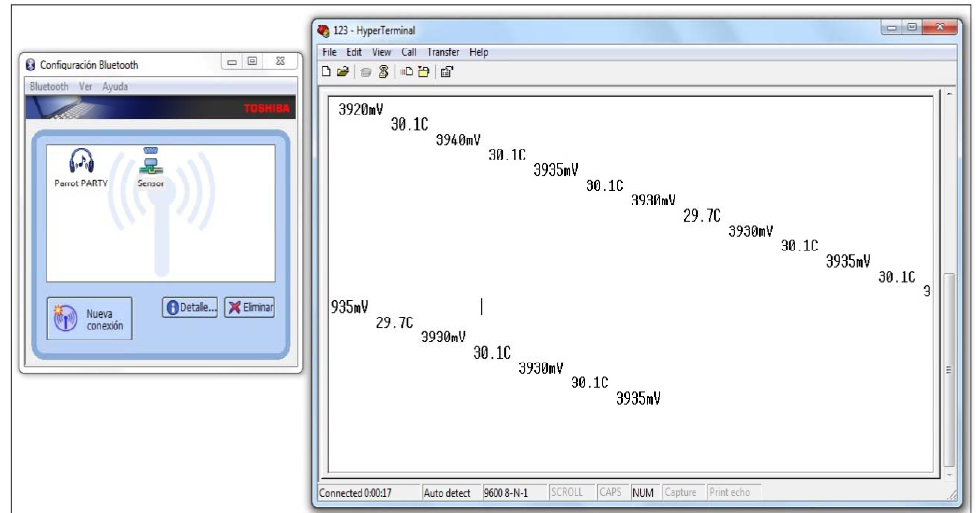
Figure 9. Receiving temperature data via